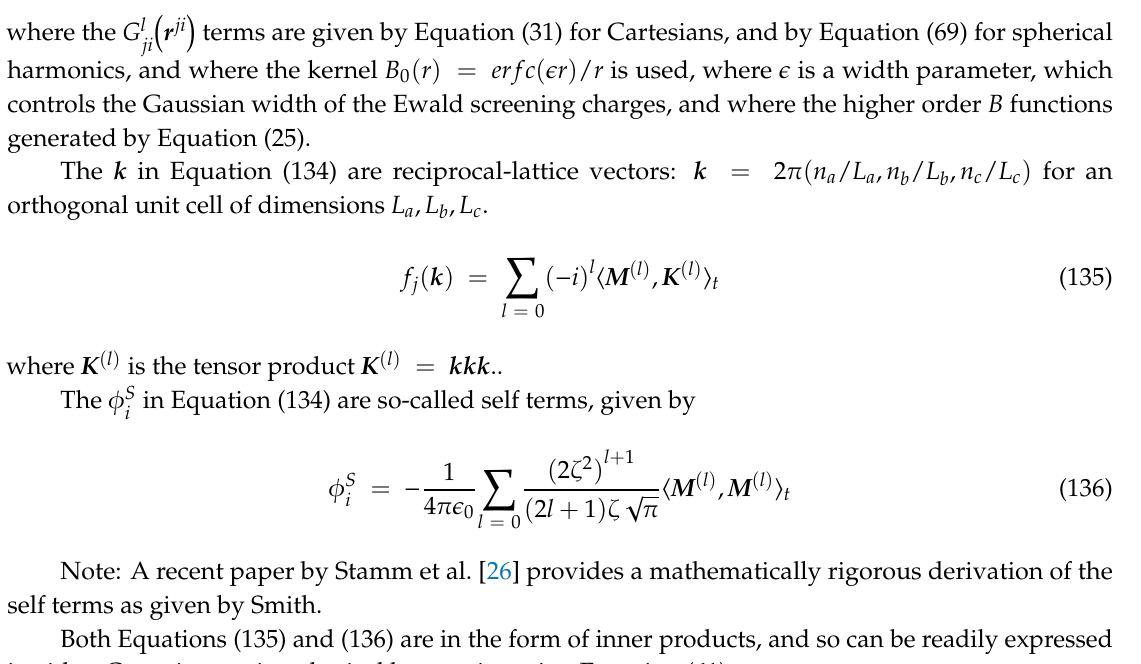
Table 1. Spherical harmonics q i ( n ) ( r ) in Cartesians up to rank 3. Adapted from Stone, and